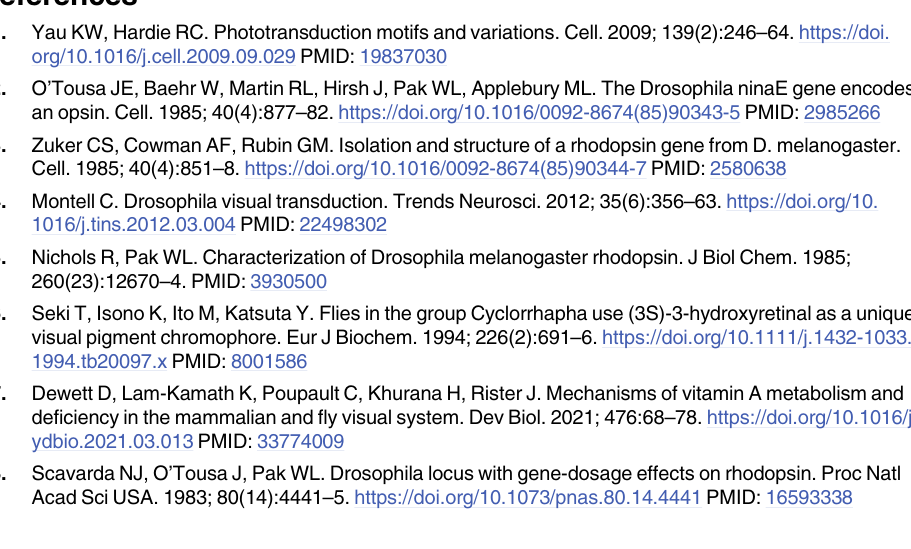
S1 Table. Differential Gene Expression comparison between ninaE wild type and ninaE G69D /+ photoreceptors. Shown is a Table based on RNA-seq counts, generated through the DESeq2 package (R v3.6.1). The data are based on three replicate samples for each geno- type. The rows have been sorted by padj (adjusted p value). Positive log2FC (log2 value of Fold Change) indicates higher expression in ninaE G69D /+ samples. S2 Table. Source data for graphs. The values of individual data points for the graphs dis- played in the